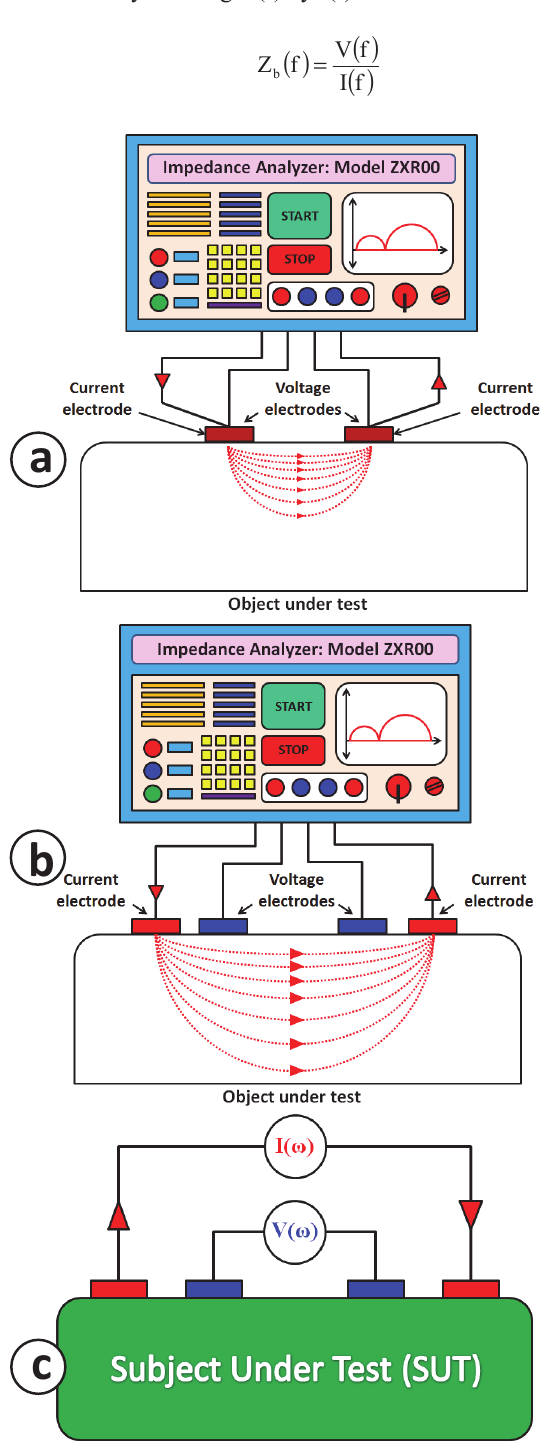
Fig.1: Electrical impedance spectroscopy (EIS) studies using the two-probe and four-probe technique. (a) EIS measurements with an impedance analyzer using two-electrode method. (b) EIS measurements with an impedance analyzer using four-electrode method. (c) Current injection and voltage measurement using the four-probe method of the impedance measurement